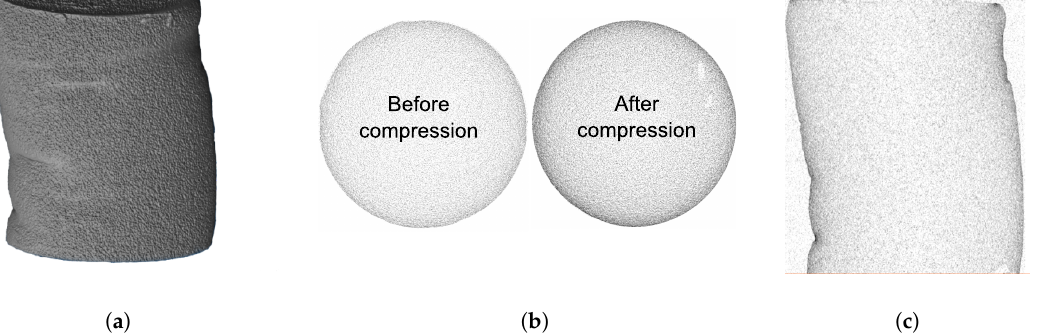
Figure 4. Reconstructions obtained from µ CT analysis for alginate aerogel crosslinked with a CaCl 2 concentration 5 g/L. ( a ) 3D volume reconstruction, ( b ) horizontal cross-cut and ( c ) vertical-cross cut of